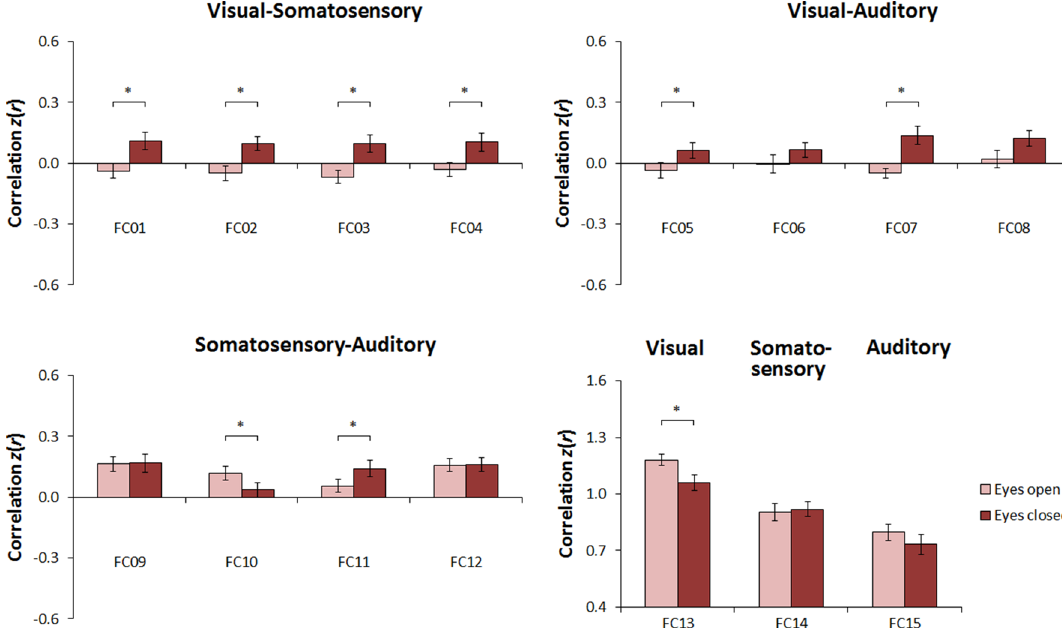
Figure 1. Effects of resting state condition in sighted individuals in Study 1. Shown is the average functional connectivity with the standard error of the mean in the eyes open condition (light red bars) and in the eyes closed condition (dark red bars) for each instance of functional connectivity examined (for details, see Table 1).